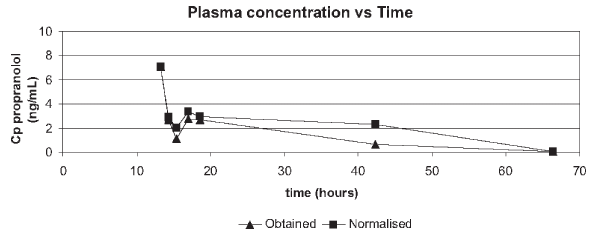
Figure 4 - Propranolol plasma levels (medians, n:6), during the surgery with hypothermic cardiopulmonary bypass, after the last administered dose in the preoperative of 8,86mg, normalized relative to the